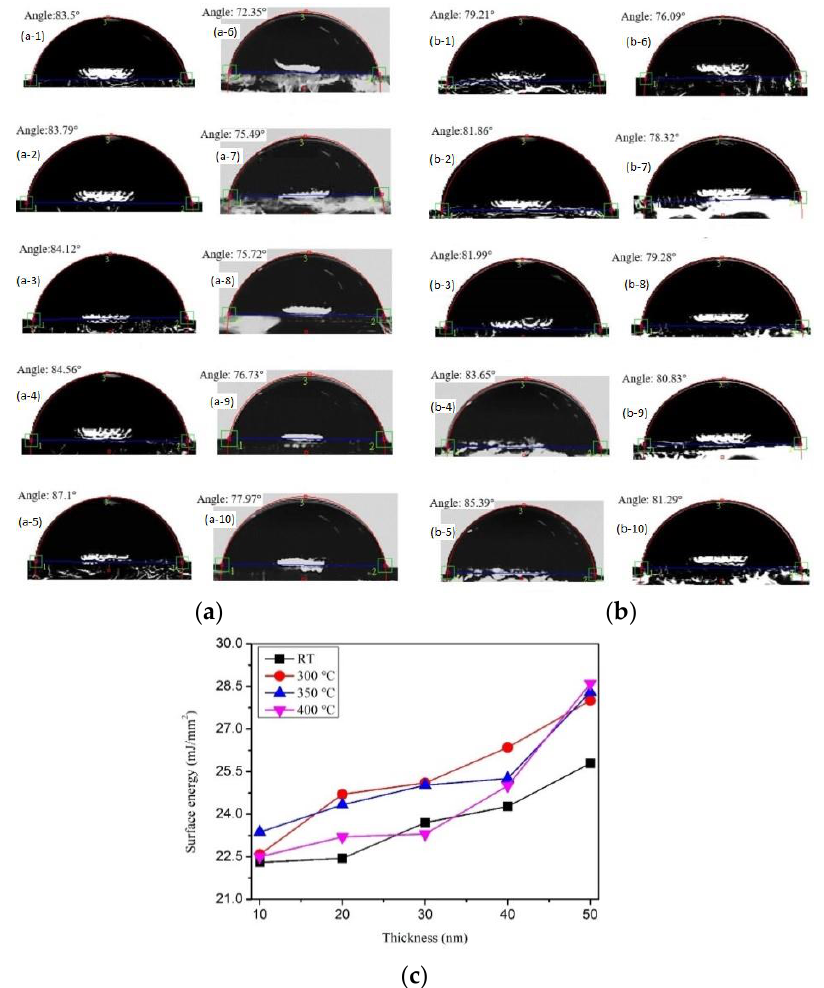
Figure 8. Contact angles of thee Co 32 Fe 30 W 38 thin films with deionized (DI) water and glycerol. ( a ) RT, ( b ) annealed at 300 °C, and ( c ) surface energy of the Co 40 Fe 40 W 20 thin films.